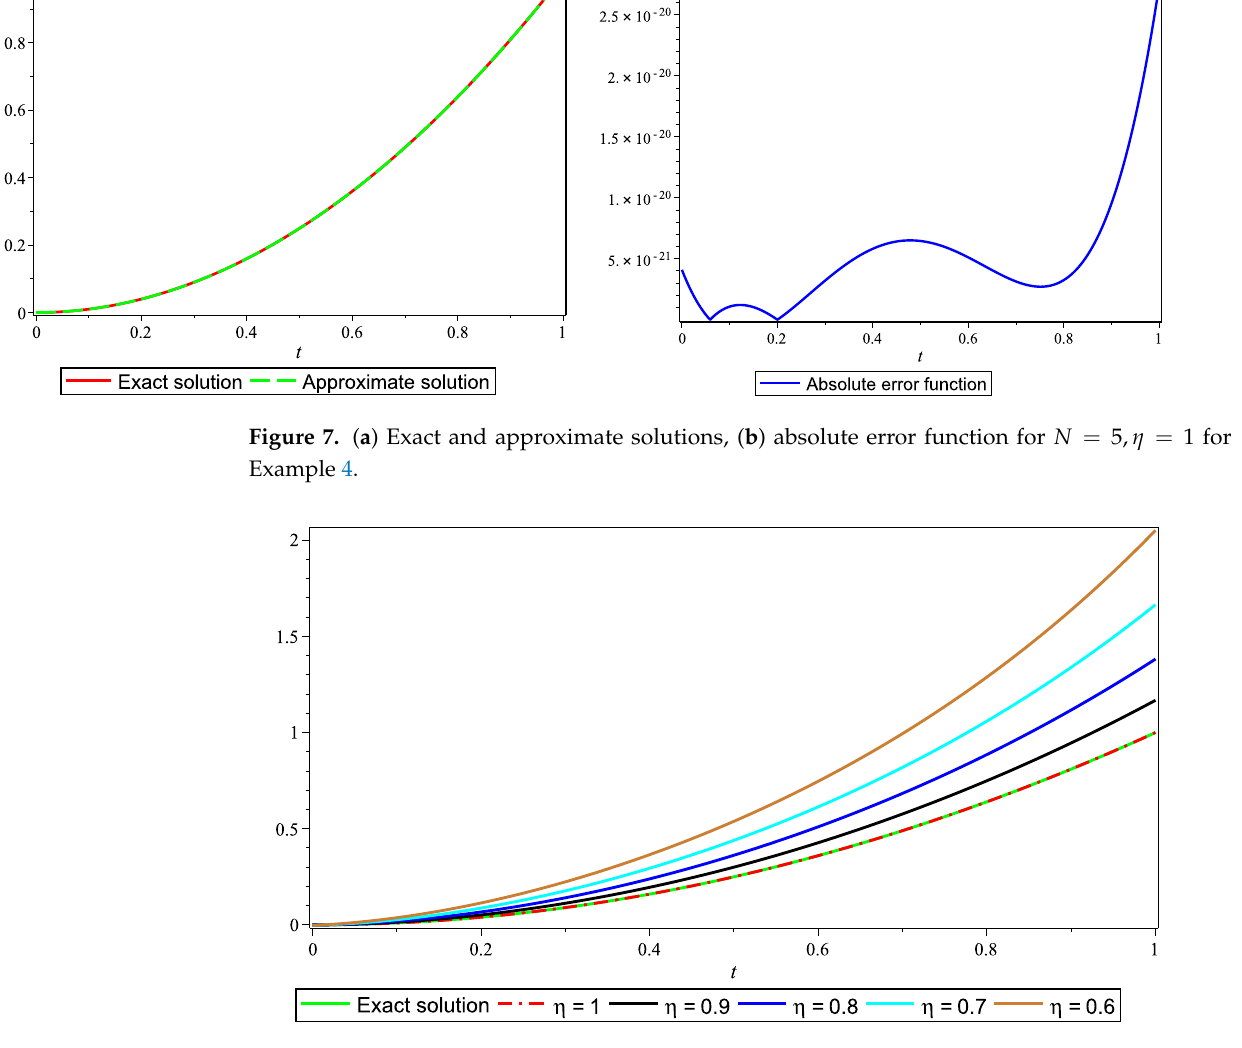
Figure 8. Approximate solutions for various values of η and N = 5 for Example